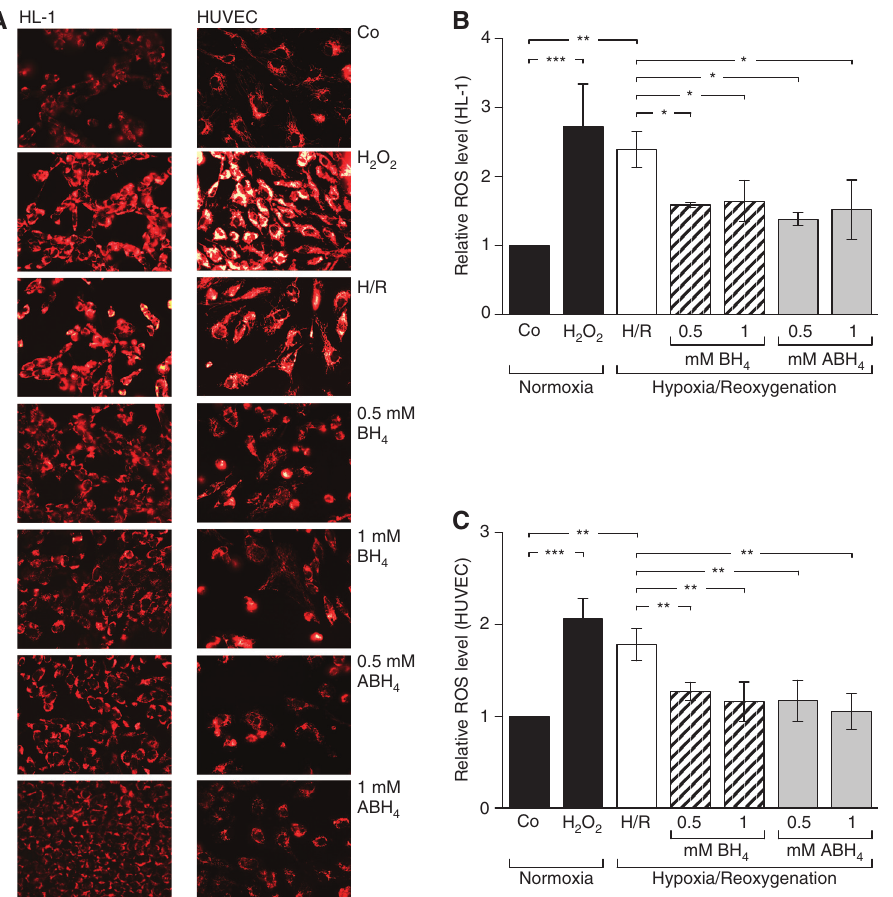
and ABH treatment on H/R-induced ROS production. HL-1 cells and HUVECs were pretreated with 0.5 or 1 mM of BH Figure 4 Effects of BH 4 4 or ABH for 5 h, followed by 45 min of H/R. Mitochondrial ROS levels were assessed by fluorescence microscopy. Representative fluores- 4 cence images are shown (A). (B and C) Summary bar graphs of BH H O was used as a positive control. Fluorescence signal of controls (Co) was set to 1.0. Data are expressed as mean ± SD (n = 3, *p < 0.05, 2 2 **p < 0.01, ***p <